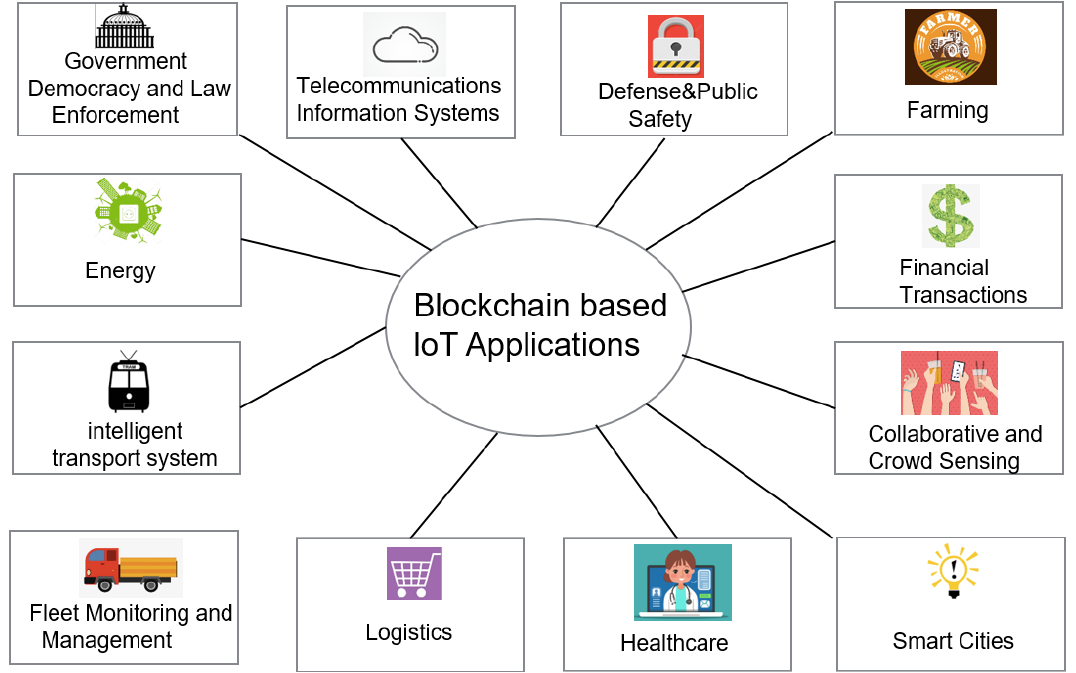
Figure 3. Blockchain-based IoT